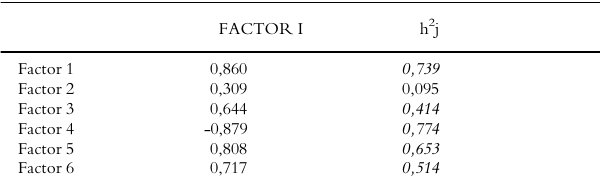
TABLE 4 SECOND-ORDER FACTOR MATRIX